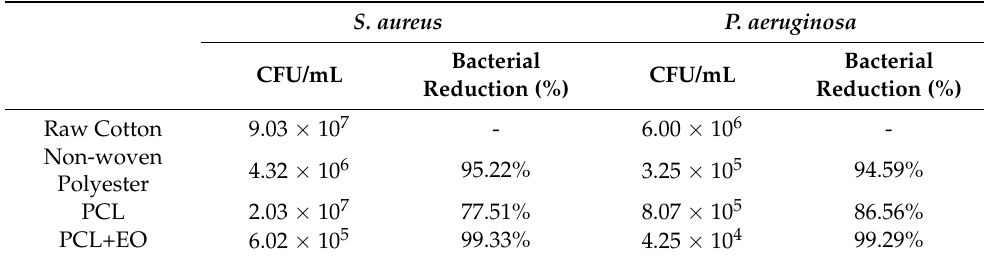
Table 4. Bacterial reduction in materials compared to raw cotton for S. aureus and P. aeruginosa . Correspondence between percentage of bacterial reduction and the respective CFU/mL. (Values reported as mean ± SD).